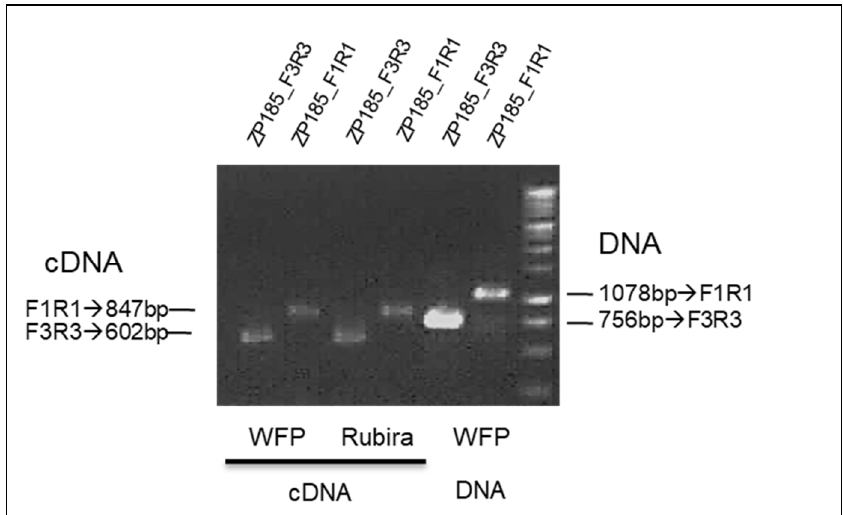
Figure 6. Genotyping with the two primers ZP185F1R1 and ZP185F3R3 specific of the TNL1 gene, of the Rubira cDNA and Weeping flower peach (WFP) cDNA and DNA.